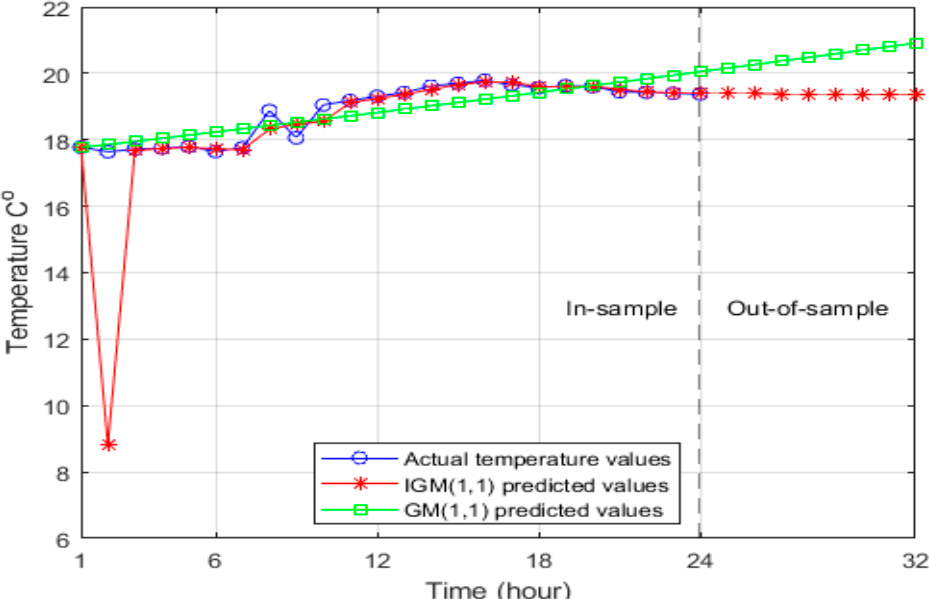
Figure 2. The actual temperature values, the simulation (in-sample), and the prediction (out-of-sample) results of the Politècnica de València University’s GHPS output temperature for the next eight hours using both the IGM (1,1) and GM (1,1) models.